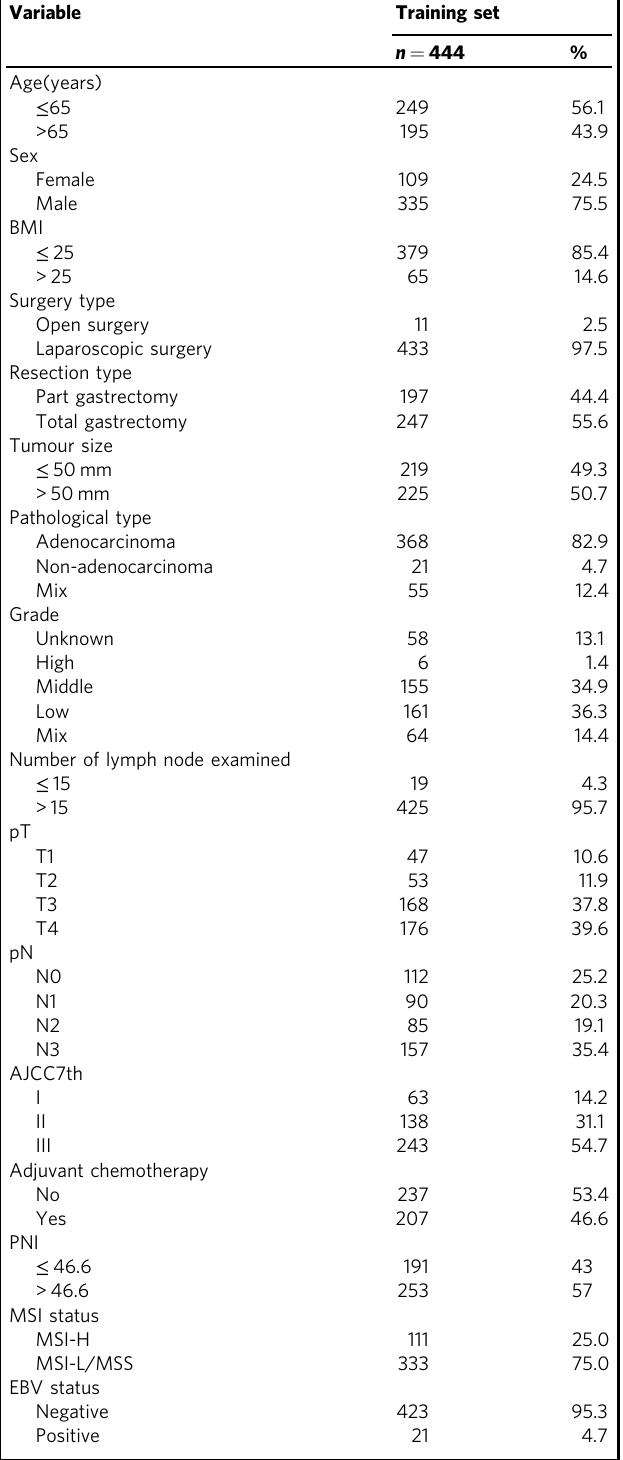
Table 1 Clinical data of internal modelling